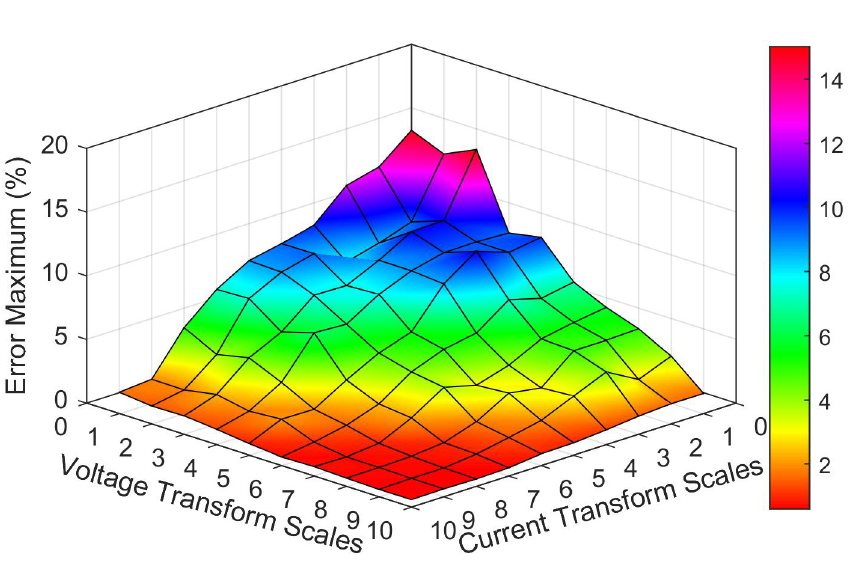
Figure 14. Maximum estimation error for different transformation scales